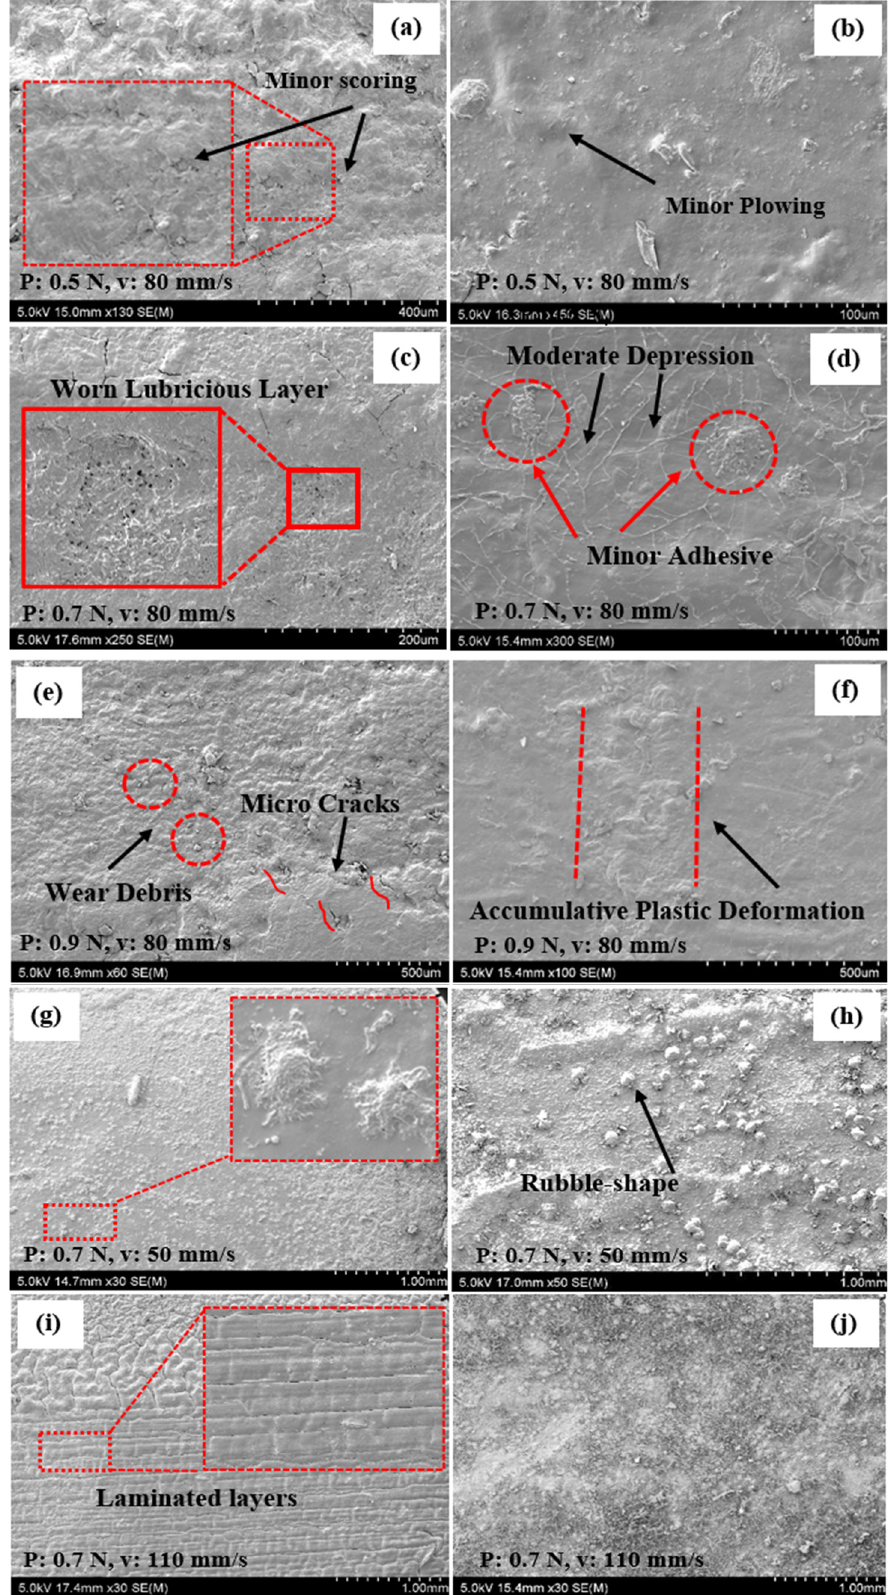
Figure 9. SEM micrographs of the wear regions for samples tested under different loads and sliding speeds in ( a , c , e , g , i ) NRHs samples and in ( b , d , f , h , j ) NCHs samples. All sliding wear tests were carried out in lubricated contact condition.